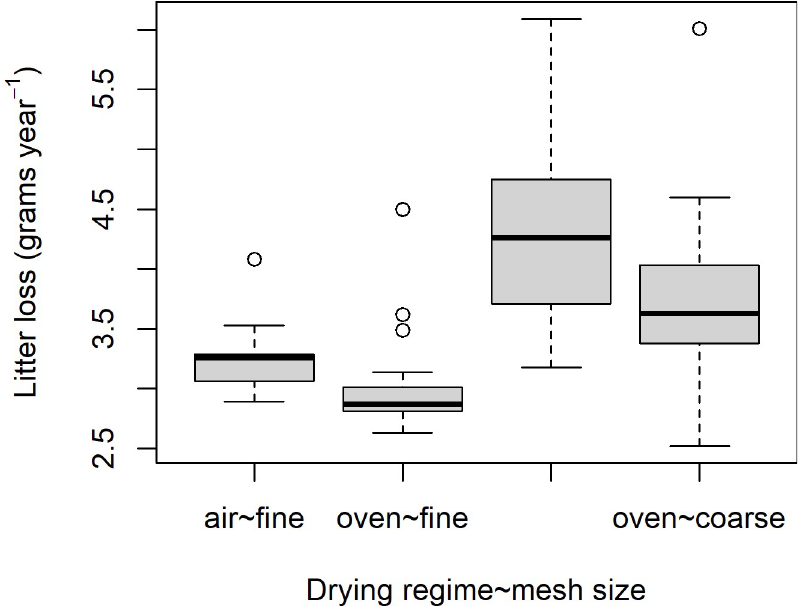
variation in loss from litterbags (log -transformed) is relatively similar with the two best 10 being the one including the dose rate of the tubes-shaped organism and the model including the 226 Ra distribution (Table 5). For all six models, the effect of all significant parameters was negative and relatively similar. Among parameter estimates the effect is clearly larger for the soil parameters organic matter fraction (OM) and pH (both log -transformed) but somewhat 10 less for log 10226 Ra and especially the dose rate (Table 6). By comparison, the parameter esti- mate of log 10228 Ra was even lower ( β = -0.07 SE = 0.04). Combining the two best models into